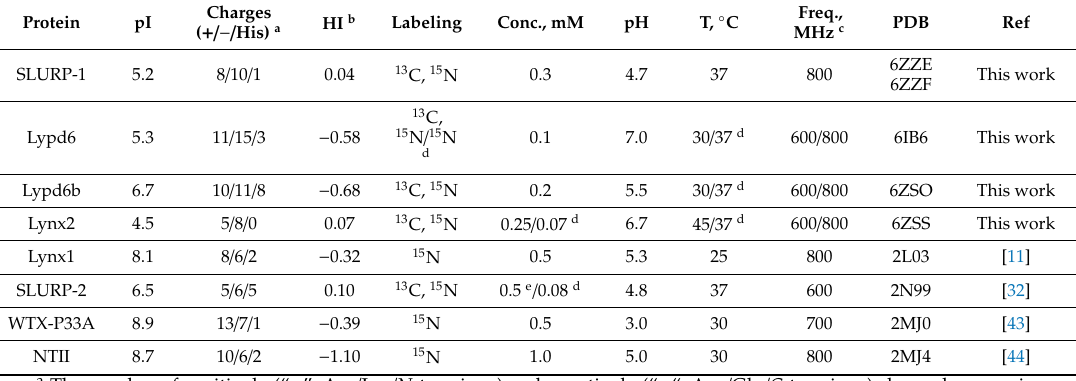
Table 1. Physicochemical properties of TFPs and experimental conditions for NMR